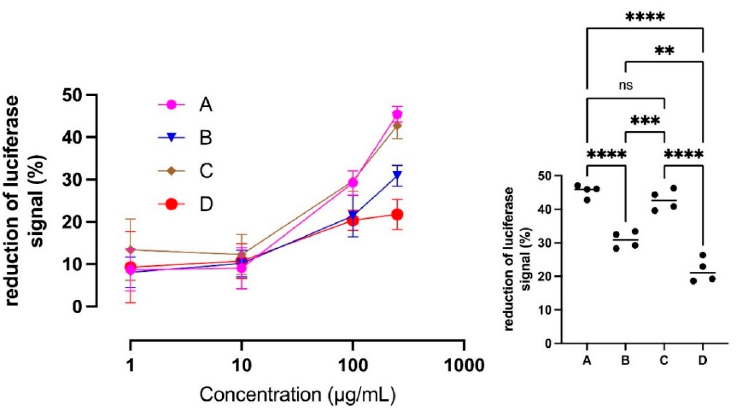
Figure 10. Anti-inflammatory activities of enocianinas. Values are reported as percentage of luciferase signal with respect to cells treated with TNF- α . The left panel shows the dose-dependent activity of the four enocianina in a concentration range between 100 and 250 µg/mL. The right panel shows the one-way ANOVA analysis followed by multi-comparison test for the data relative to the 250 µg/mL concentration (** p < 0.01, *** p < 0.005, **** p < 0.0001).